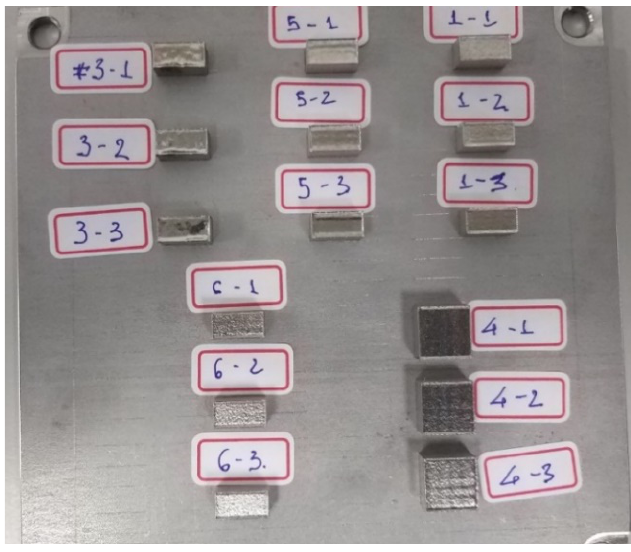
Figure 2. Illustration of the as-built IN718 parts manufactured via L-PBF.